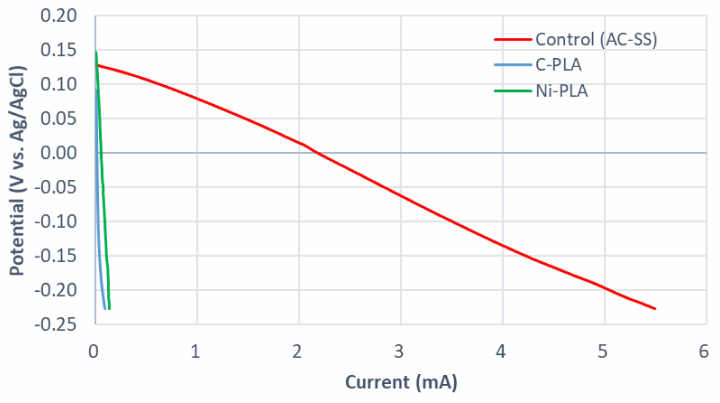
Figure 2. Linear sweep voltammetry (LSV) curves of the test cathode